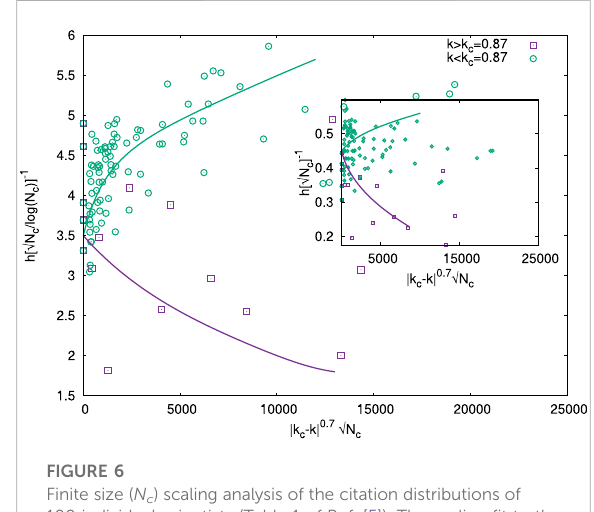
FIGURE 5 Scaling behavior for the h -index (in the range 185 ≤ h ≤ 4421) for cluster size distributions at the percolation point (with size N on the square lattice; 10 6 < N < 10 9 ). The fi gure shows (cid:1)(cid:1) √ (cid:1)(cid:1)(cid:1)(cid:1)(cid:1)(cid:1)(cid:1)(cid:1)(cid:1)(cid:1)(cid:1)(cid:1)(cid:1)(cid:1)(cid:1)(cid:1)(cid:1)(cid:1)(cid:1) (cid:4) the best fi t of h to N / logN . The inset shows the statistical Σ ( h ( i ) − h γ ( i )) 2 / Σ deviations Σ (cid:3) to the scaling forms h ~ N γ i d i 1 and h ~ N γ / log(N ) with respect to γ , where i represents the individual (random) realization of the percolating system with the corresponding h (= h d ) value obtained from the simulation result and the scaling fi t ( h γ ) from the aforementioned scaling relations. The inset shows that the statistical deviation becomes minimum for the scaling with the log correction term, although with a value of γ somewhat above 1/2.